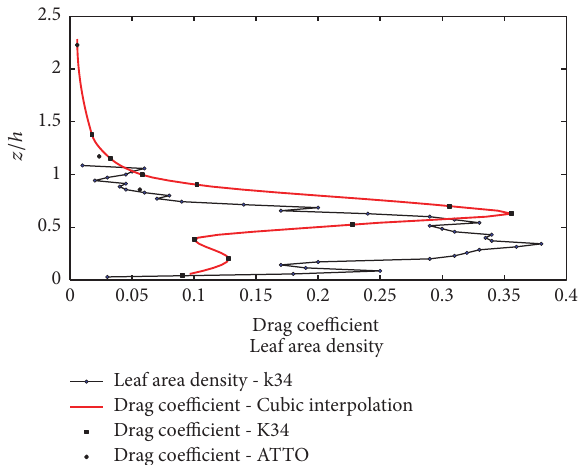
Figure 2: Leaf area density vertical profile (source: T´ota et al. [27]) and drag coefficient